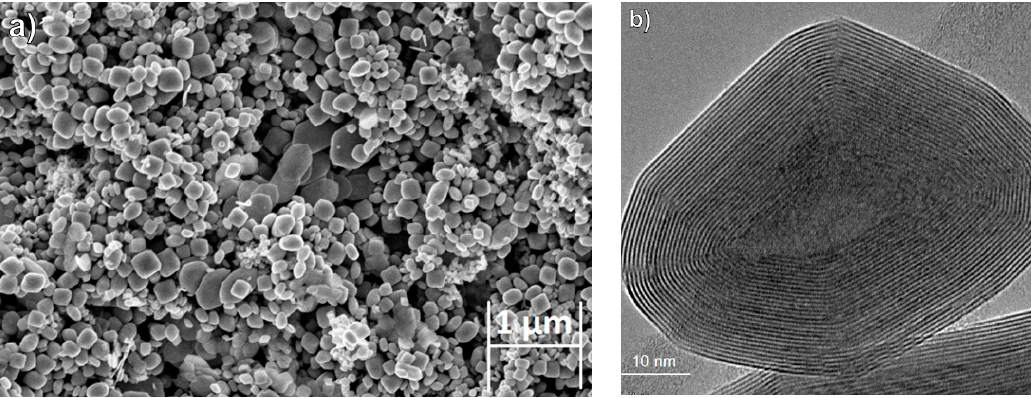
Figure 1. ( a ) High-resolution scanning electron microscopy (HRSEM) image of Re:IF-MoS 2 nanoparticles powder in In-lens detector 5 kV; ( b ) high-resolution transmission electron